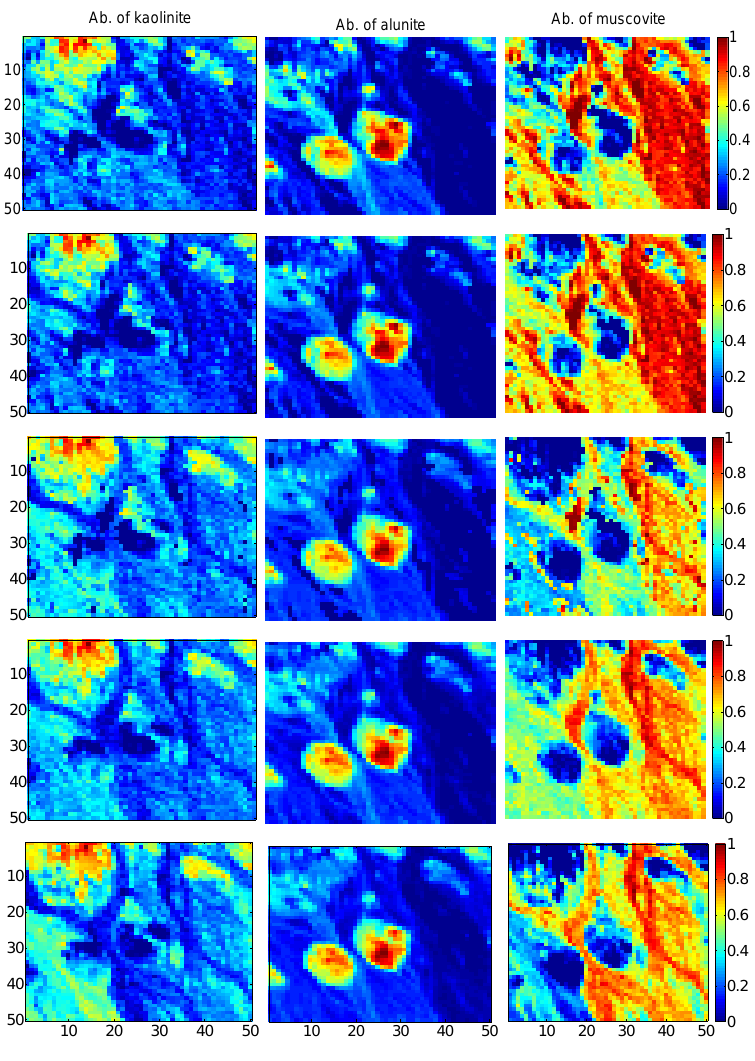
Figure 5. Abundance maps estimated by the proposed NU-BGBM and the compared methods for the selected real Cuprite HSI. From top to bottom: FCLS, GDA, semi-NMF, BPOGM, and NU-BGBM. RSS FCLS